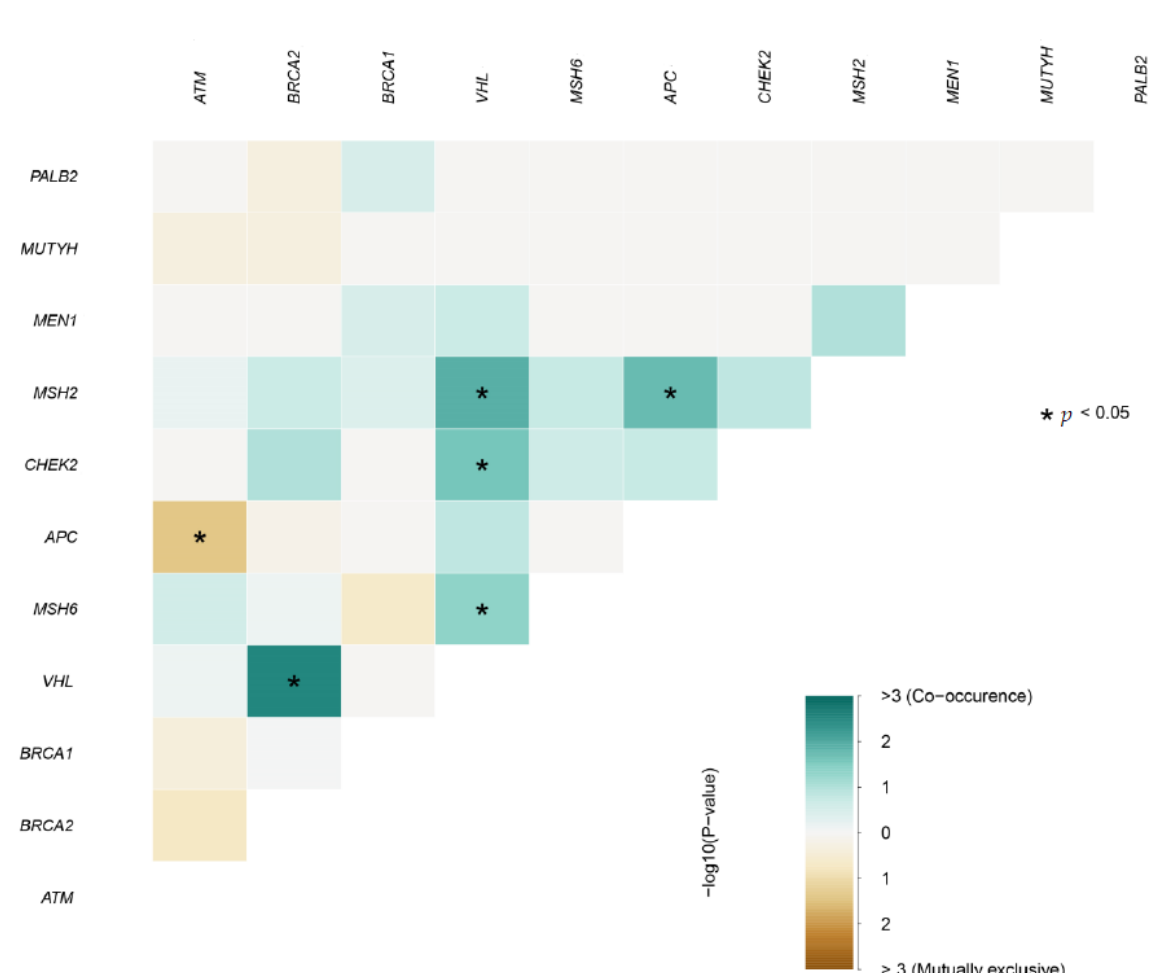
Figure 4. Co-occurrence plot shows the gene pairs with co-occurring and mutually exclusive events. Degree of significance indicated in the legend, with only results of the genes harboring deleterious mutation shown. Genes: PALB2 [1]; MUTYH [1]; MEN1 [1]; MSH2 [6]; CHEK2 [7]; APC [7]; MSH6 [8]; VHL [12]; BRCA2 [31]; ATM [31].